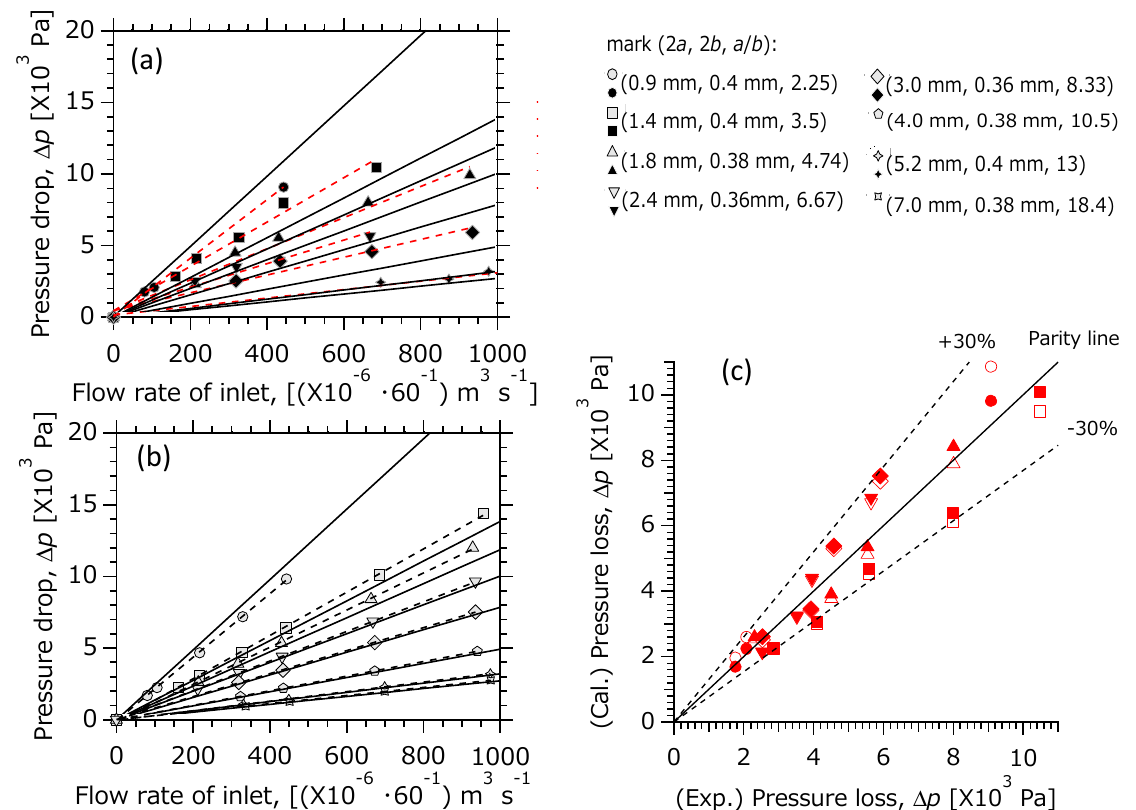
Figure 6. ( a , b ) Profiles of pressure drop against flow rate of inlet. Filled black: experiment, filled gray: CFD, solid line: analytical solution. ( c ) Parity plots. Filled red: Exp.–Cal.(1D) (= analytical solution), blank: Exp.–Cal.(3D) (= CFD). Circle: (2 a ,2 b , a / b ) = (0.9 mm, 0.4 mm, 2.25), square: (1.4 mm, 0.4 mm, 3.5), triangle: (1.8 mm, 0.38 mm, 4.74), upside-down triangle: (2.4 mm, 0.36 mm, 6.67), diamond: (3.0 mm, 0.36 mm, 8.33), pentagon: (4.0 mm, 0.38 mm, 10.5), cross (5.2 mm, 0.4 mm, 13), × -mark: (7.0 mm, 0.38 mm, 18.4).